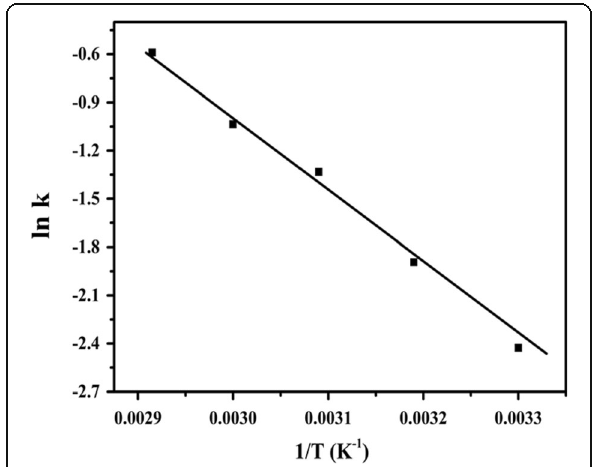
Fig. 12 Plot of rate constant against 1/T for the reduction of 4-NP by NaBH 4 in the presence of AuNPs as catalyst at different temperatures